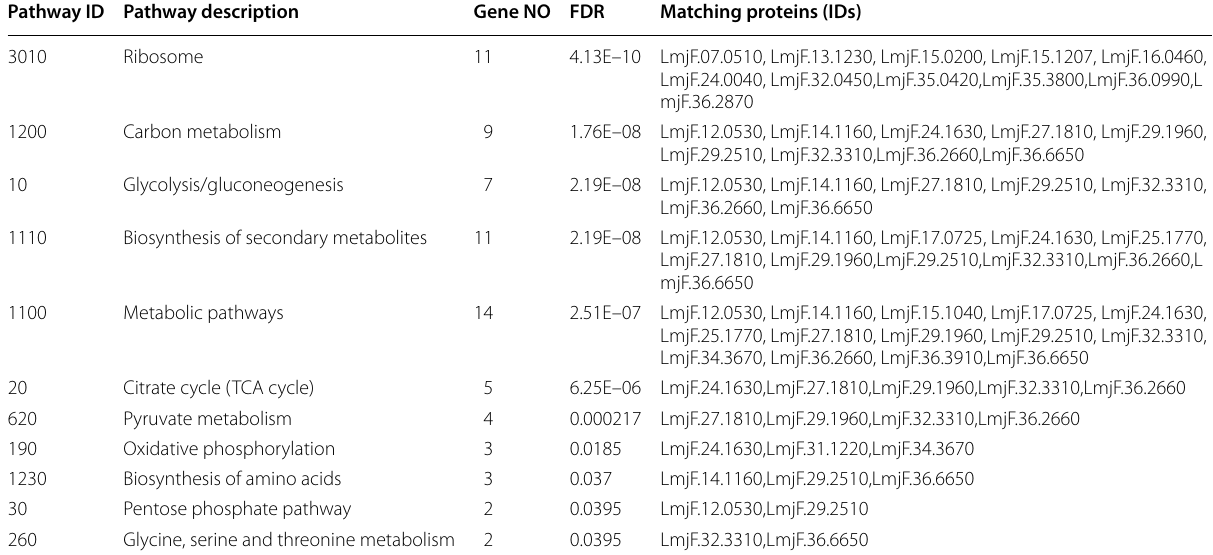
FDR false discovery rate